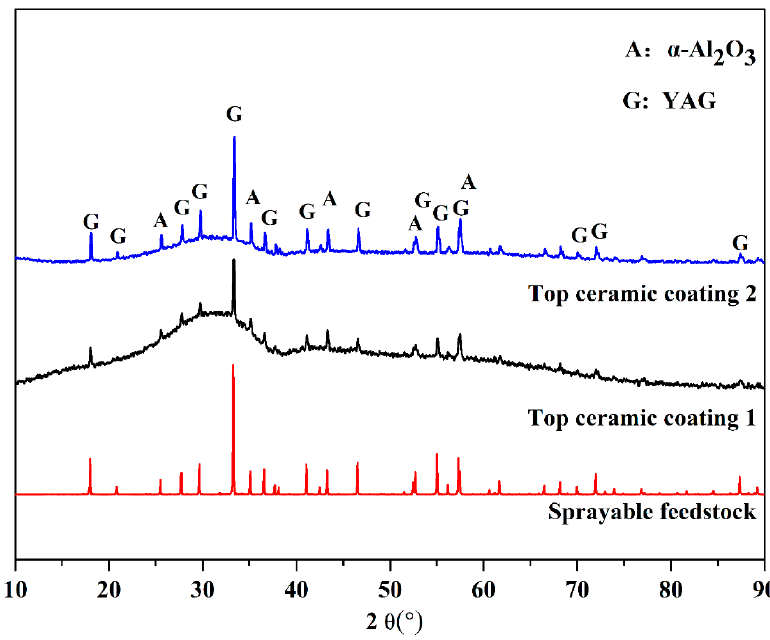
Figure 9. XRD patterns of sprayed feedstock and corresponding ceramic coatings.